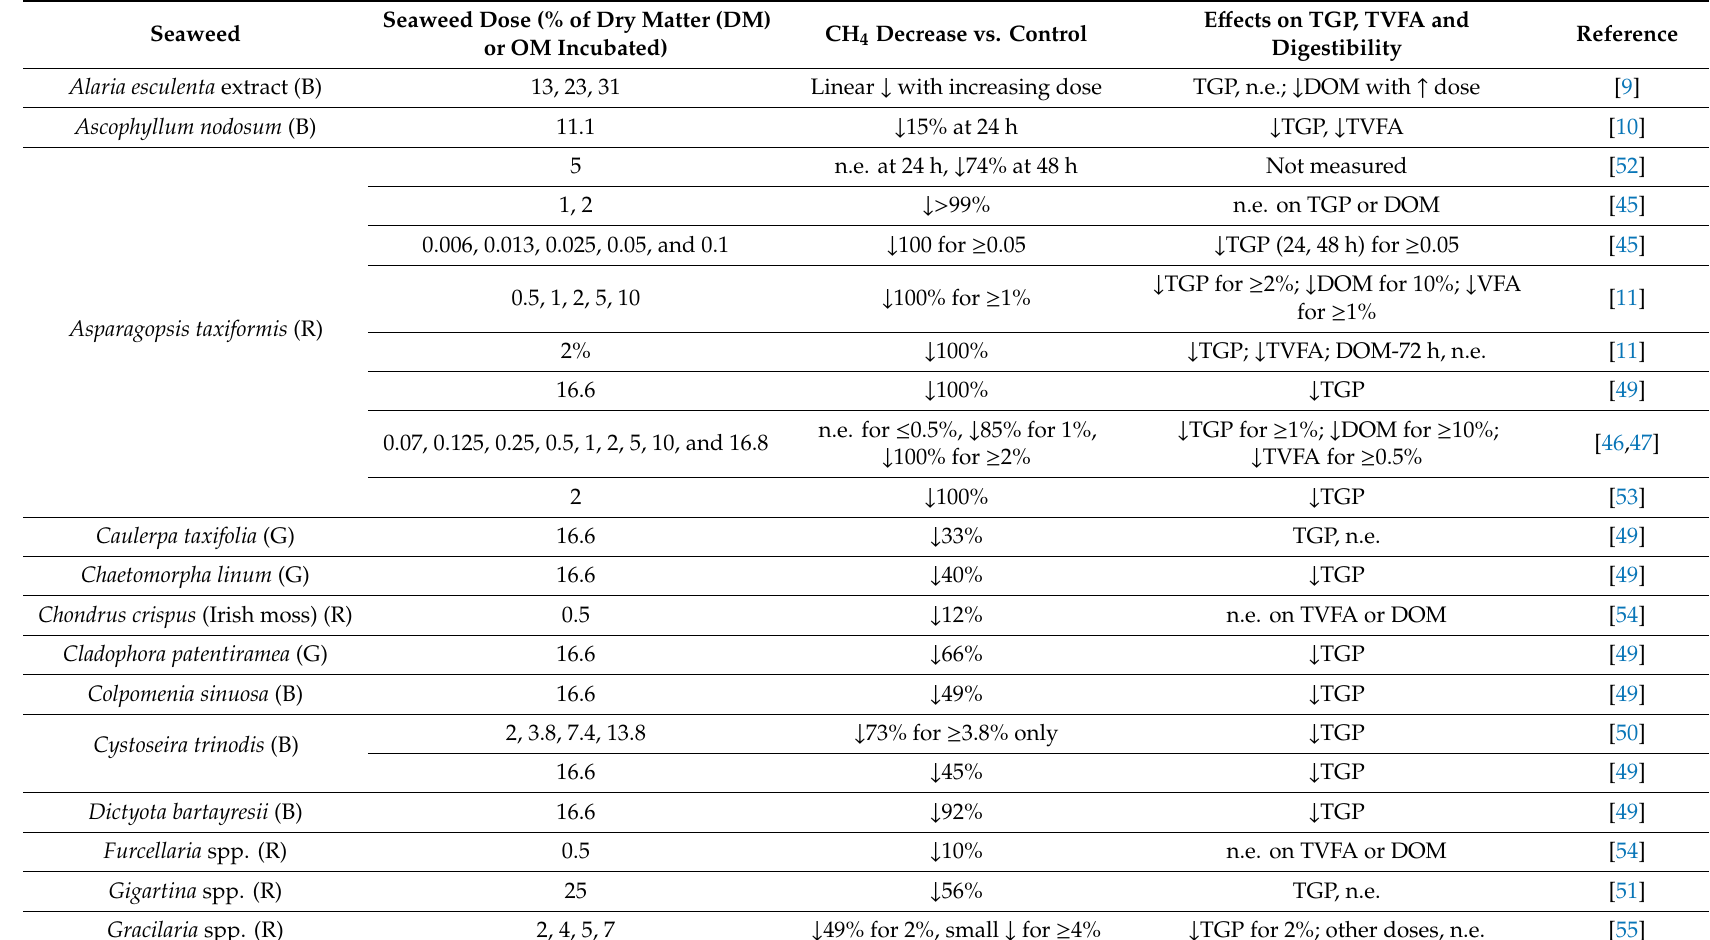
Table 1. Summary of seaweeds with CH 4 mitigation e ff ects in